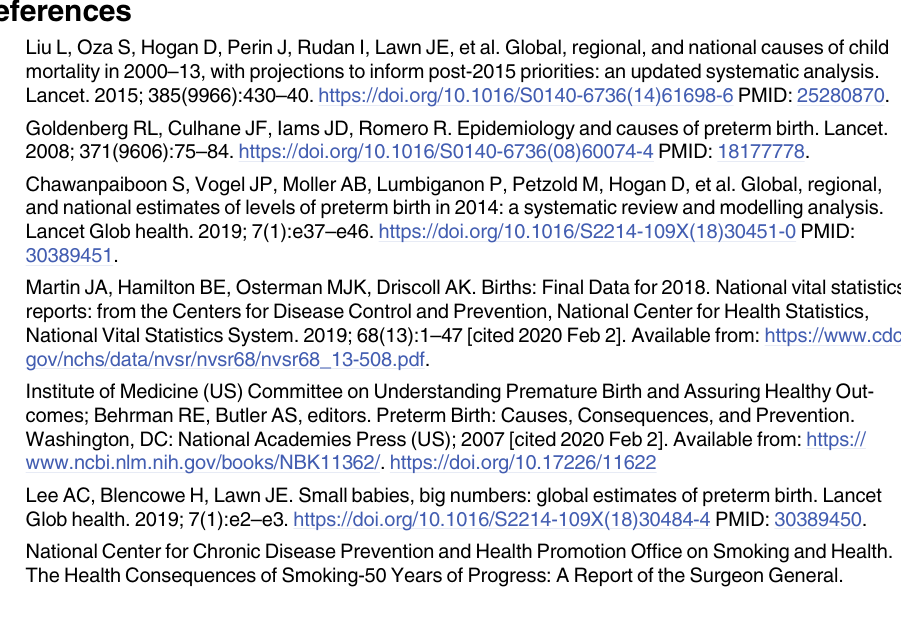
S9 Table. Sensitivity analysis for the associations of timing of maternal smoking with pre- term birth after additional adjustment for a propensity score. S10 Table. Sensitivity analysis for the associations of maternal smoking with preterm birth after additional adjustment for a propensity score. S11 Table. Sensitivity analysis for the association between smoking cessation at various periods and preterm birth after additional adjustment for a propensity